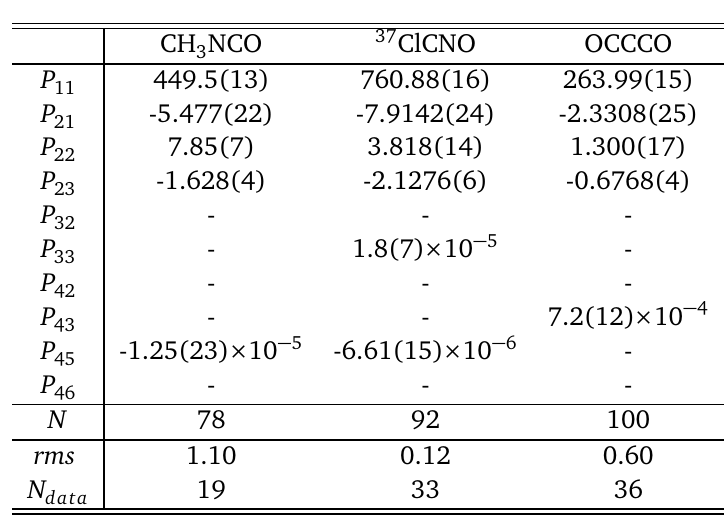
Table 1: Optimized Hamiltonian parameters ( P , in cm − 1 units) for the selected ij bending degree of freedom of CH NCO, 37 ClCNO, and OCCCO. Values are provided 3 together with their associated uncertainty in parentheses in units of the last quoted digits. The total vibron number, N , the obtained rms of the fit, and the number of reported bending band origins considered in the fit are also